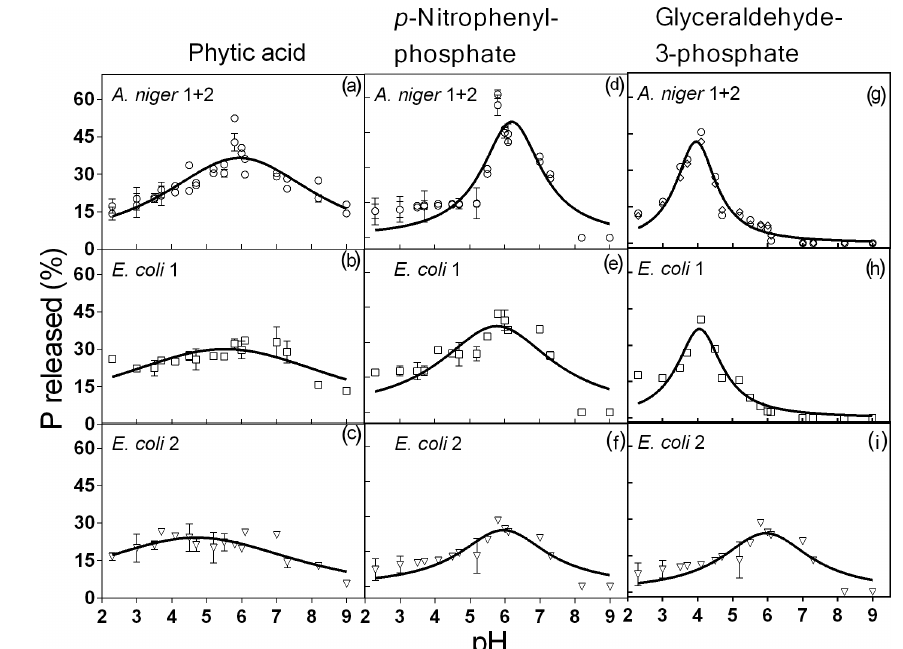
Figure 2. Phytase activity measured at different pH levels with phytic acid, p NP and G3Phosphate as substrates. Four purified phytases (two isolated from A. niger and two from E. coli ) were evaluated. In cases where significant differences between enzymes (analyzed using F tests) were not found, a unique curve was fitted. Each point represents the average of three observations minus the controls described in Sect. 2. Bars represent the standard error of the mean. The coefficients of each adjusted model are given in Table